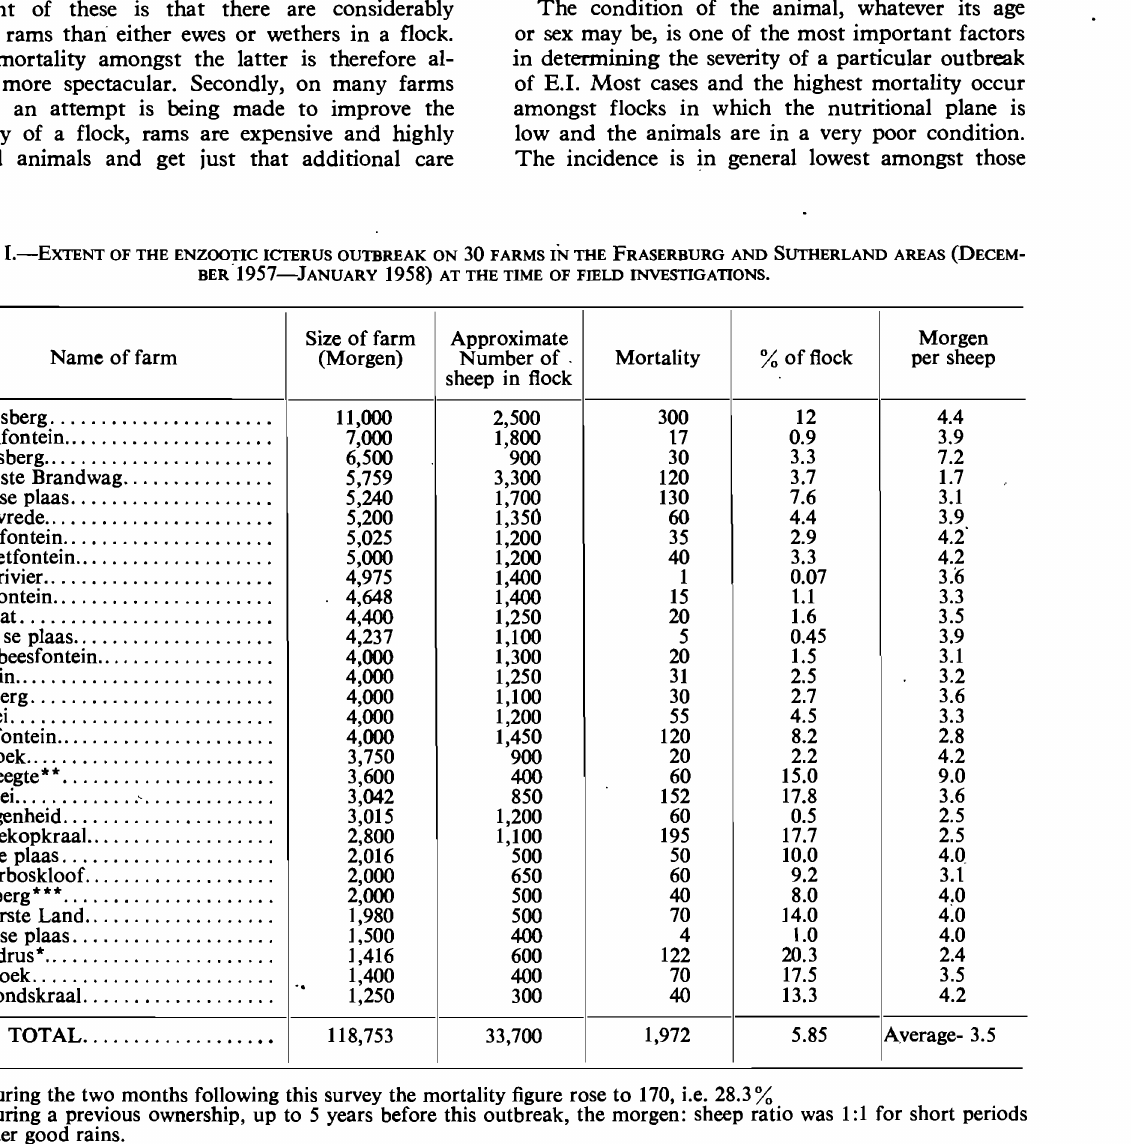
TABLE I.-EXTENT OF THE ENZOOTIC ICTERUS OUTBREAK ON 30 FARMS IN THE FRASERBURG AND SUTHERLAND AREAS (DECEM BER·1957-JANUARY 1958) AT THE TIME OF FIELD INVESTIGATIONS. Size of farm